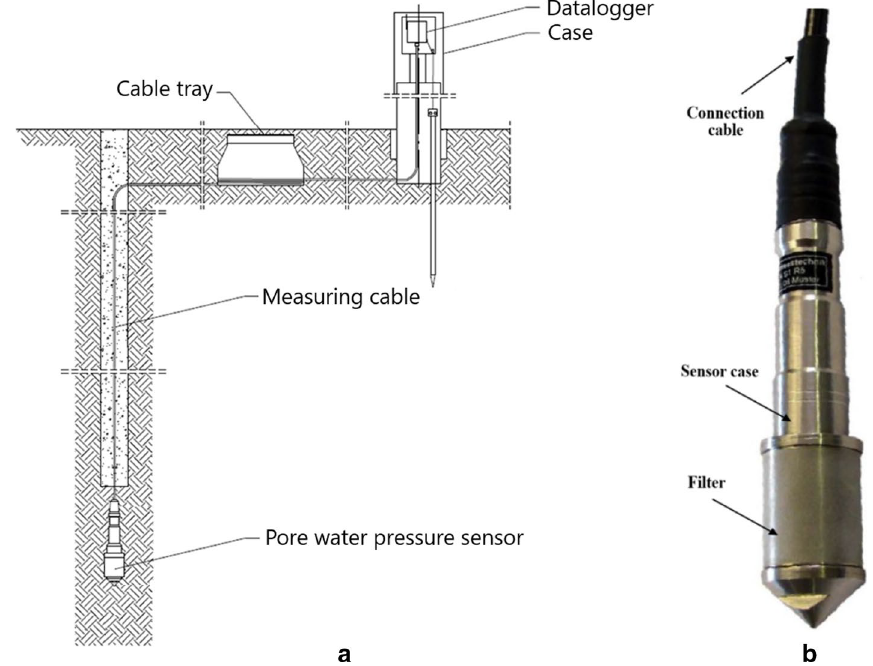
Fig. 7 a Diagram of an automatic measuring station of water pore pressure installation; b Diagram of a pore water pressure sensor